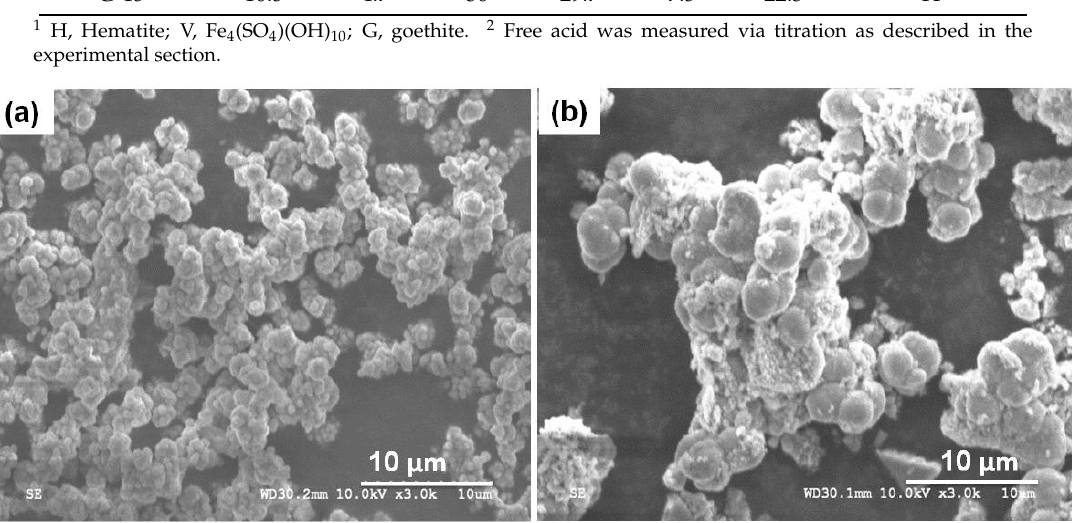
Figure 6. SEM images of the precipitates: ( a ) 0 g/L initial H 2 SO 4 and ( b ) 15 g/L initial H 2 SO 4 . Other conditions: 6 g/L Fe(III), 30 g/L Cu(II), 11g/L Cl¯, 1 h, 150 °C.